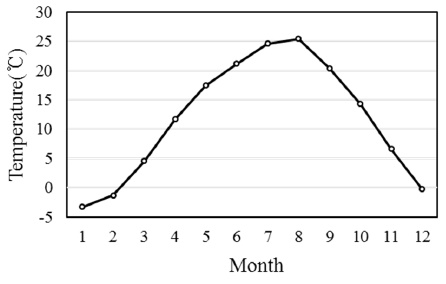
Figure 8. Seoul weather condition. Table 2. Properties of building parts and input data.